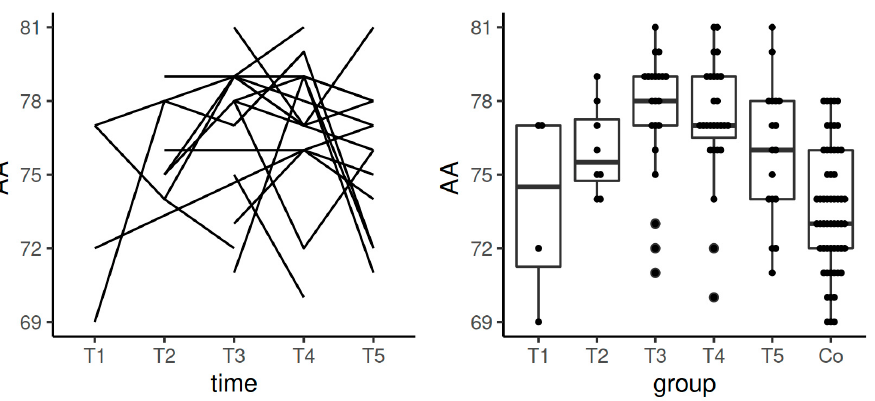
Figure 4. Spaghetti plot of the data from the longitudinal study (left), and swarmplot with boxplot of the same data together with the data from the control group (right)—the results of AA in EX-